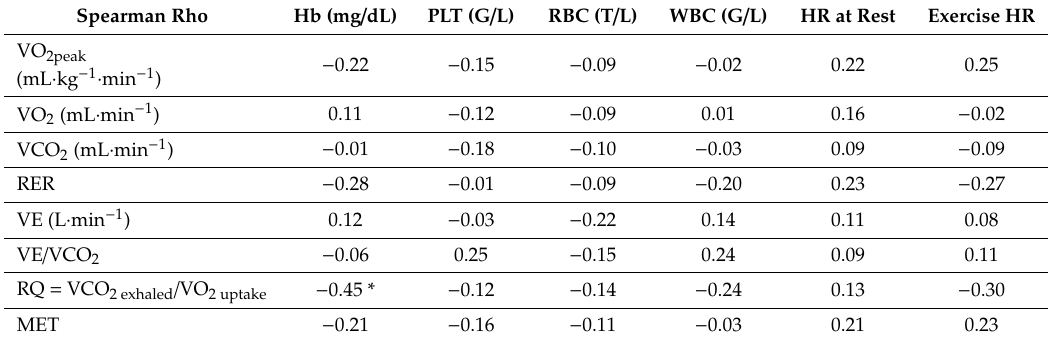
Table 7. Correlation of the results of the exercise stress test with the parameters of blood count and heart rate in the study group of children in total. Values of p < 0.05 were considered statistically